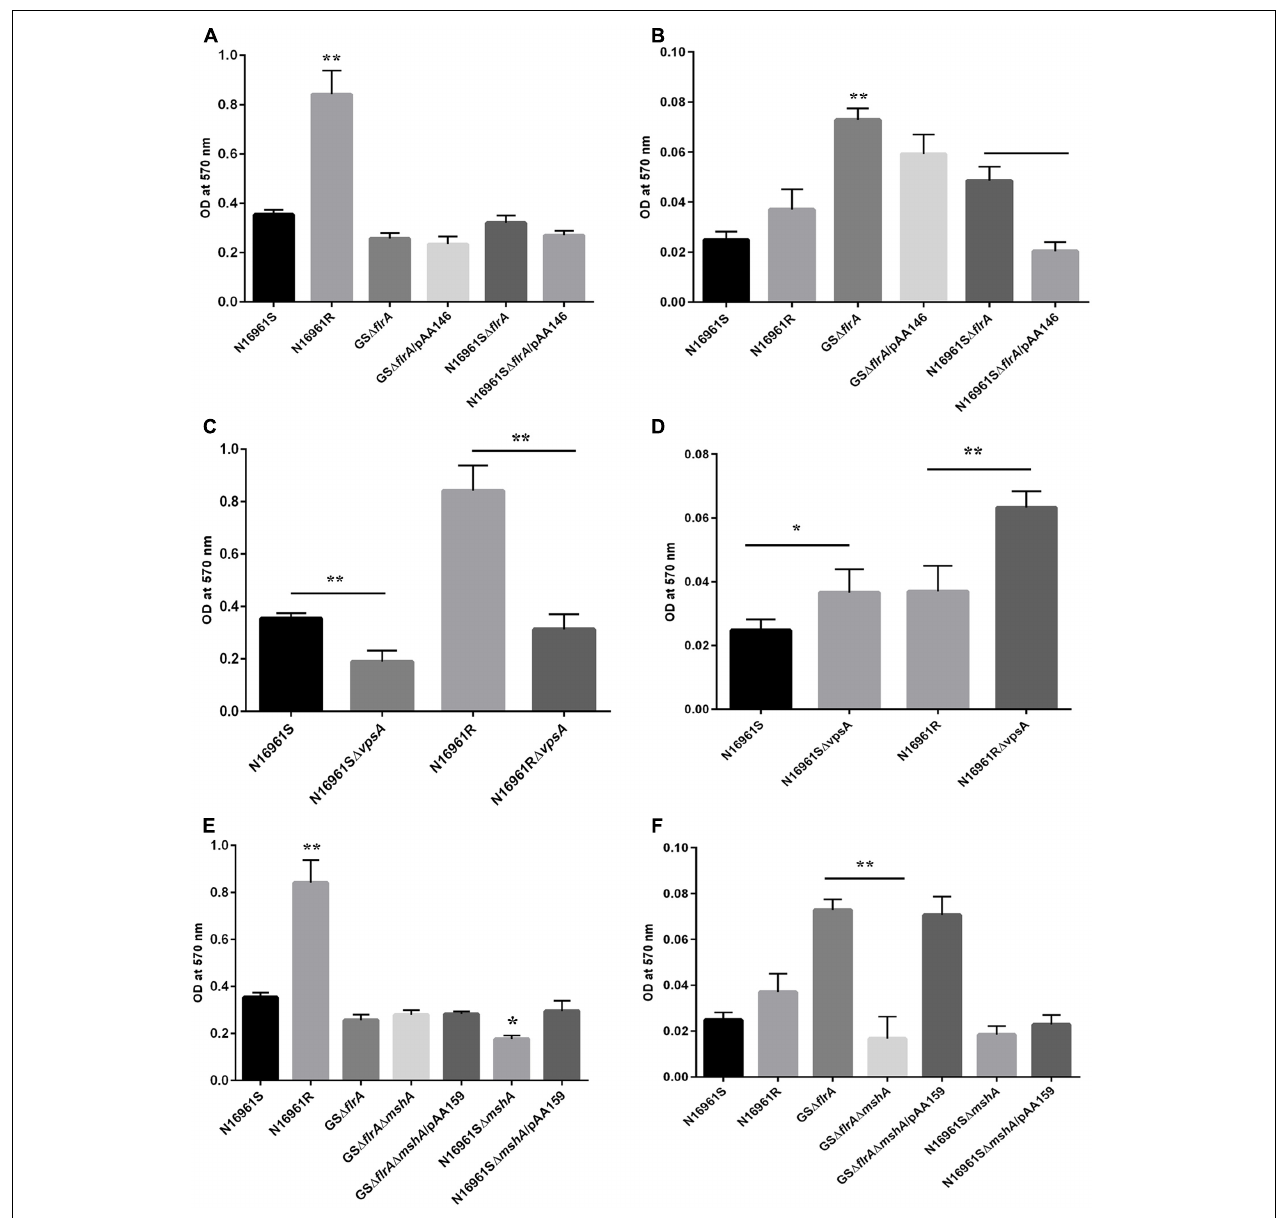
FIGURE 3 | Quantitative measurement of biofilm produced by V. cholerae strain. Quantification of biofilm produced by V. cholerae strains grown in: nutrient-rich L-broth (A,C,E) , and in nutrient-poor FSLW (B,D,F) . The results represent the average of six independent experiments. All the values are expressed as mean ± (cid:49) standard error (SE) calculated from the six readings for each strain. A p -value of < 0.05 was considered statistically significant; ∗∗ p < 0.01, ∗ p < 0.05.